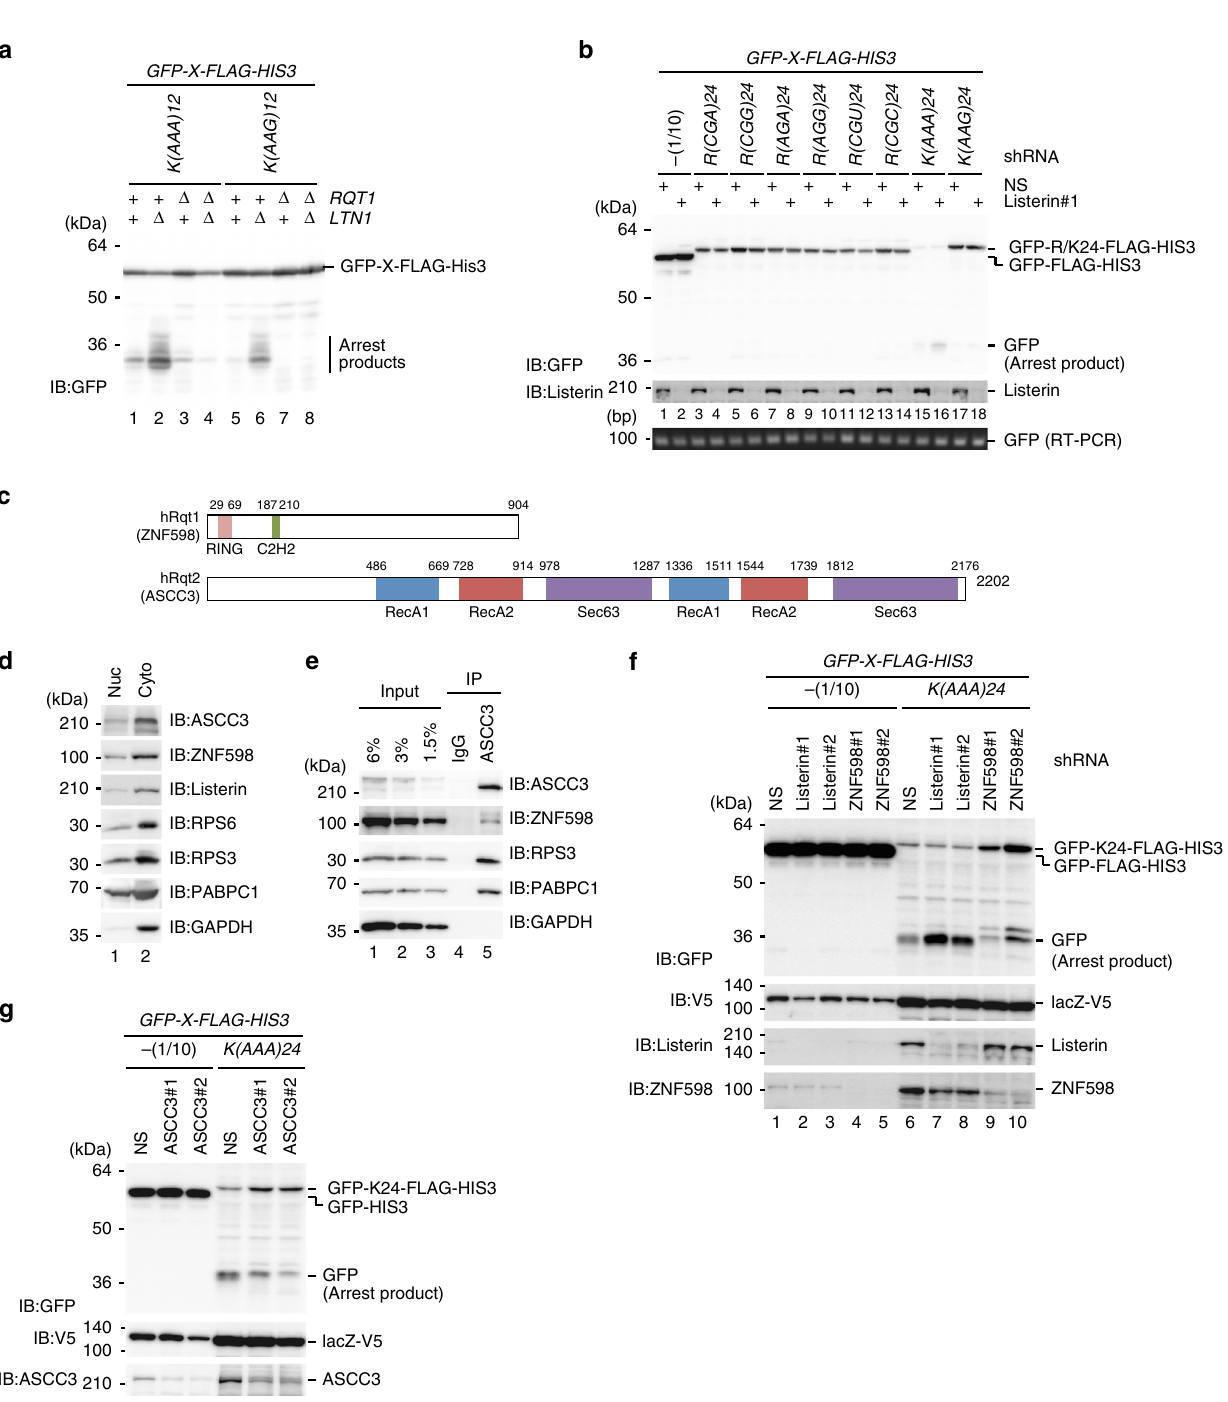
Fig. 7 ASCC3, a human homolog of yeast Rqt2 is required for RQC induced by poly(A) sequence. a Rqt1 factors were required for RQC induced by poly-lysine sequences in yeast. b The AAA repeat induces RQC in mammalian cells. c Schematic drawing of alignment of the domain structure of ZNF598/hRqt1 and ASCC3/hRqt2. d ZNF598 and ASCC3 were localized mainly in cytosol. e ZNF598 was co-puri fi ed with ASCC3. f ZNF598 is involved in translation repression and the production of RQC substrate by K(AAA)24 sequence. g ASCC3 is a homolog of Rqt2 in mammalian